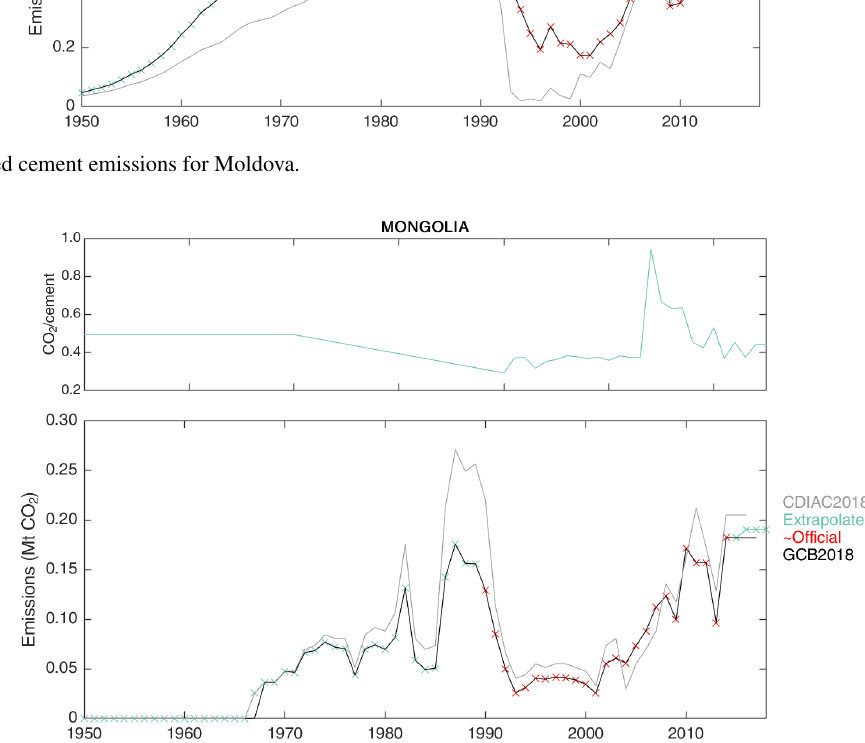
Figure C32. Revised cement emissions for